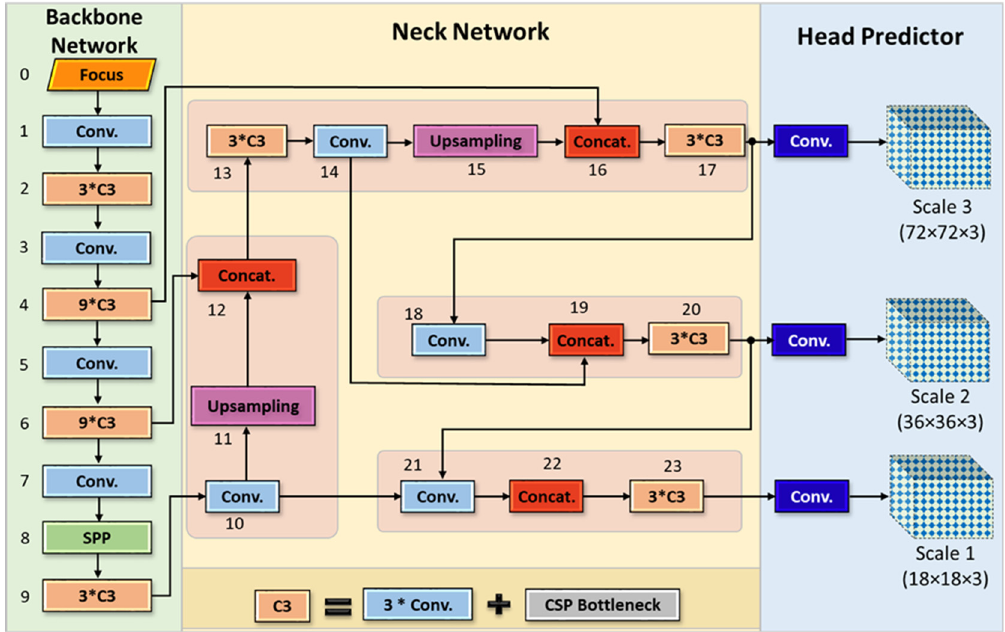
Figure 8. Schematic diagram of VPP-based YOLOv5 to detect and classify the real VP public road images. The * indicates the convolutional process.